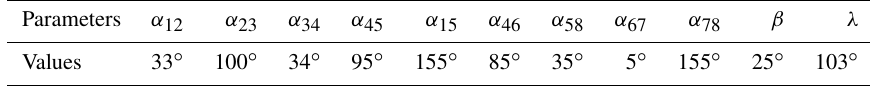
Table 4. The parameters for Example 1. Parameters